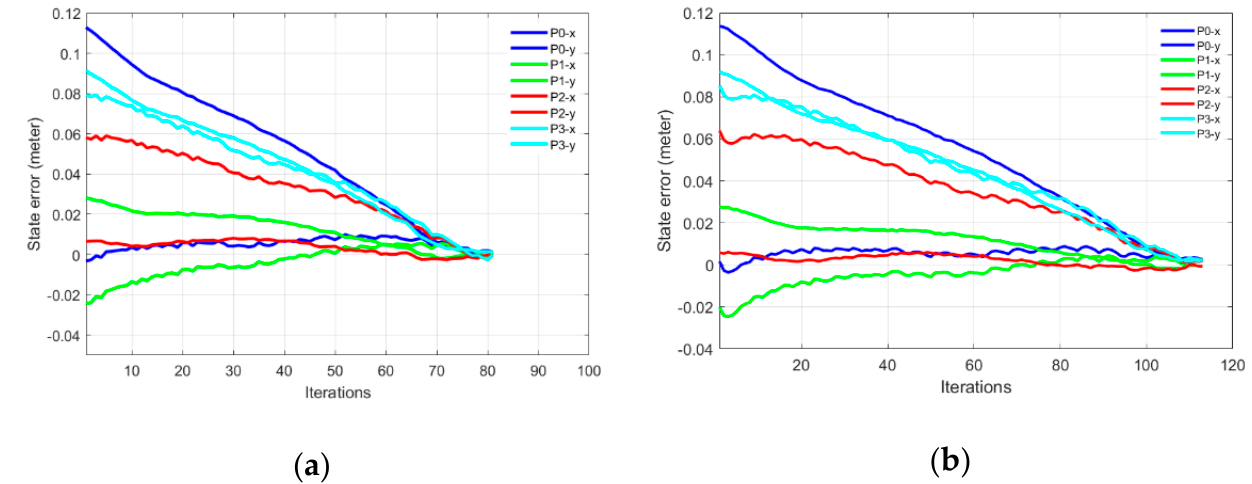
Figure 10. Comparison of an IBVS task between a mixed frame Cartesian velocity controller and a joint velocity controller ( a ) feature error decay for Cartesian velocity ( b ) feature error for joint velocity.